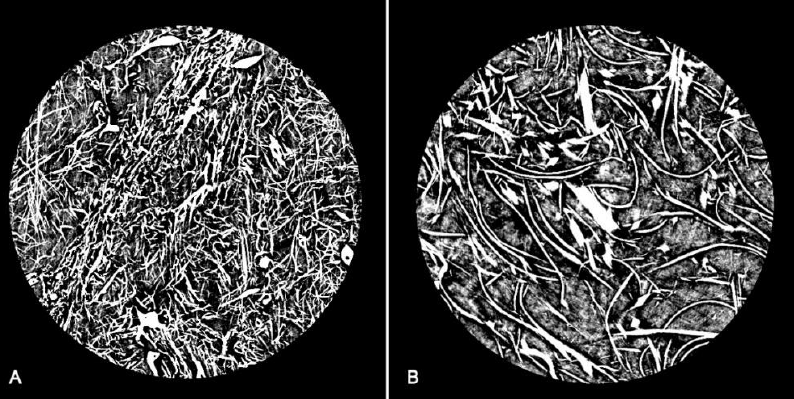
Figure 3. Axial section of the P3 filter from X-ray micro-CT images: ( A ) fine layer consisting of pol- ypropylene fibers with a predominantly cylindrical section (rod-like); ( B ) coarser layer consisting of fibers with a thin, predominantly rectangular section (plate-like), with a greater rarefaction of the fiber distribution.